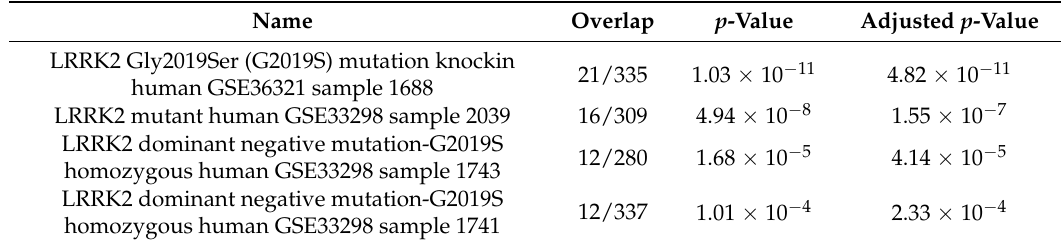
Table 6. Top ranked four LRRK2 KO/KI experiments in “Single Gene Perturbations from GEO